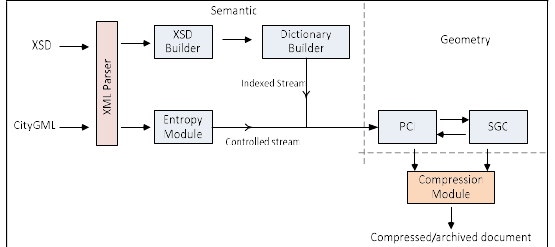
Figure 5. The CitySAC encoding workflow in encodeGML operation (Siew and Abdul Rahman, 2013).